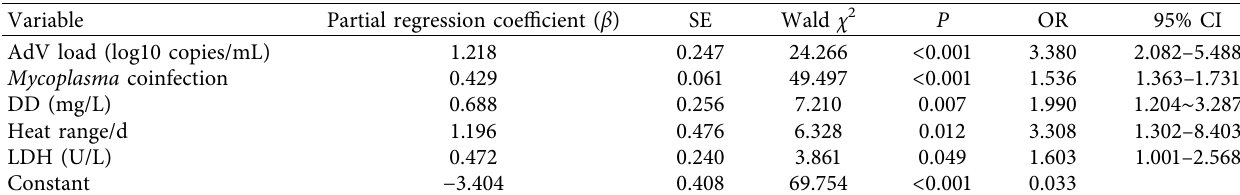
Table 3: Logistic regression analysis of patients with AdV infection.